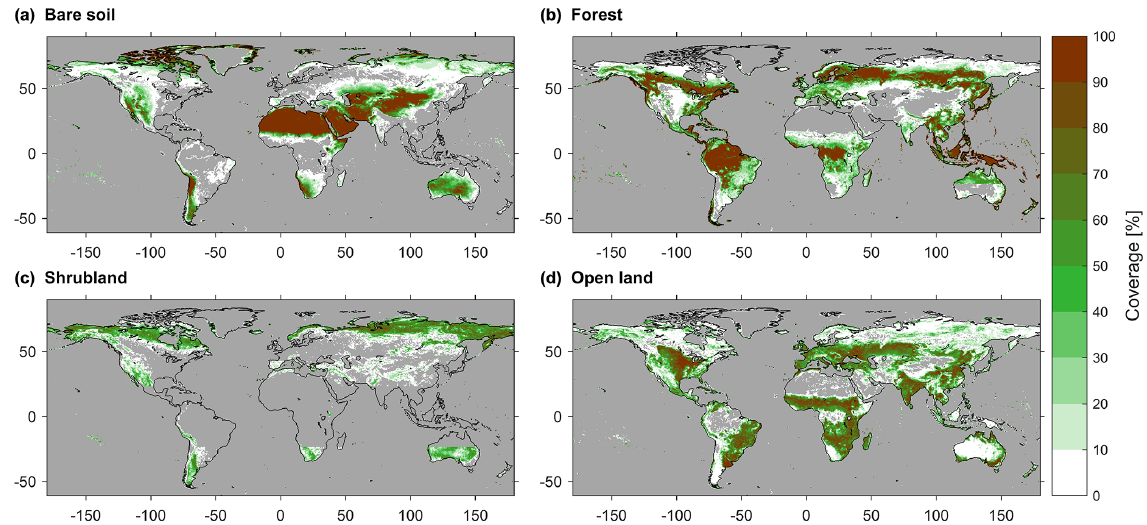
Figure A1. The fraction of the CLM4.5 grid cells covered by (a) bare soil, (b) forest, (c) shrubland, and (d) open